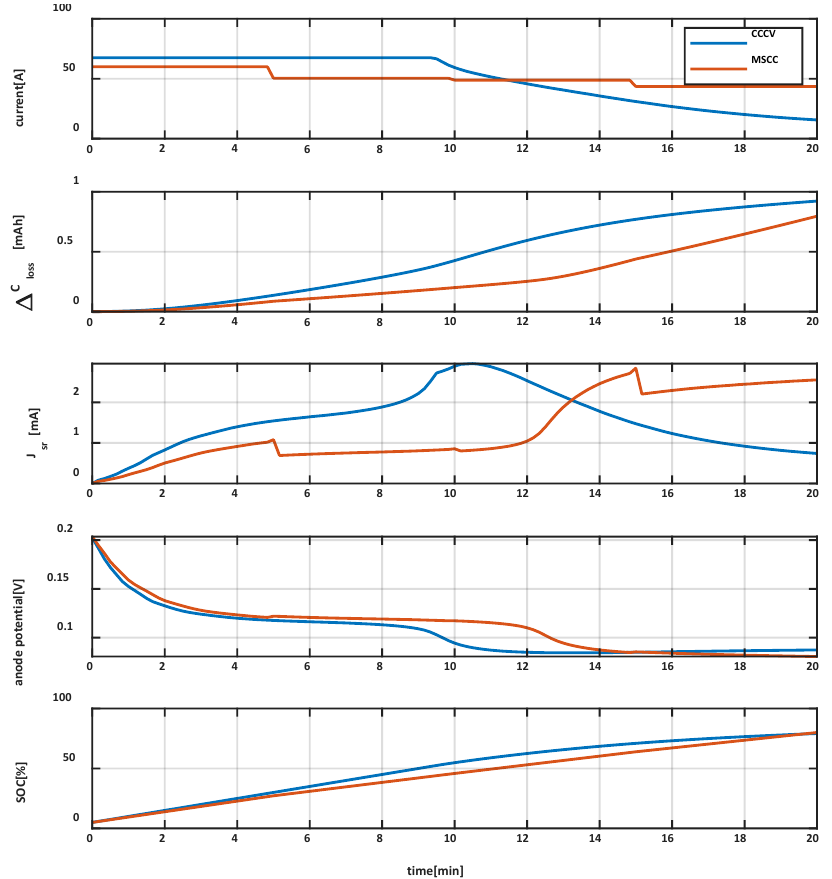
Figure 4. Trajectories computed for a fixed charging time of 20 min, at T = 35 °C, for a cell at the Beginning of Life (BOL) in a State of Charge (SOC) range of 5–80%.